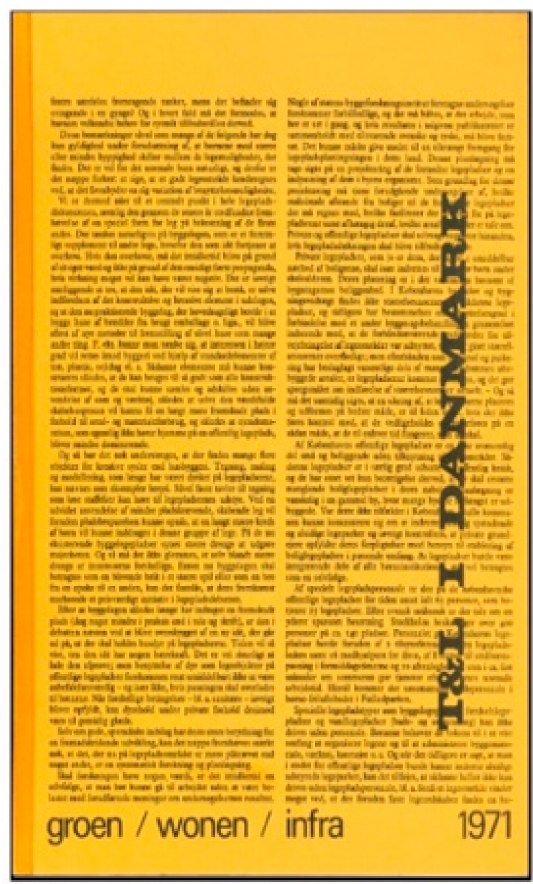
Figure 19. Excursion guide for landscape architecture students Wageningen to Denmark in 1971